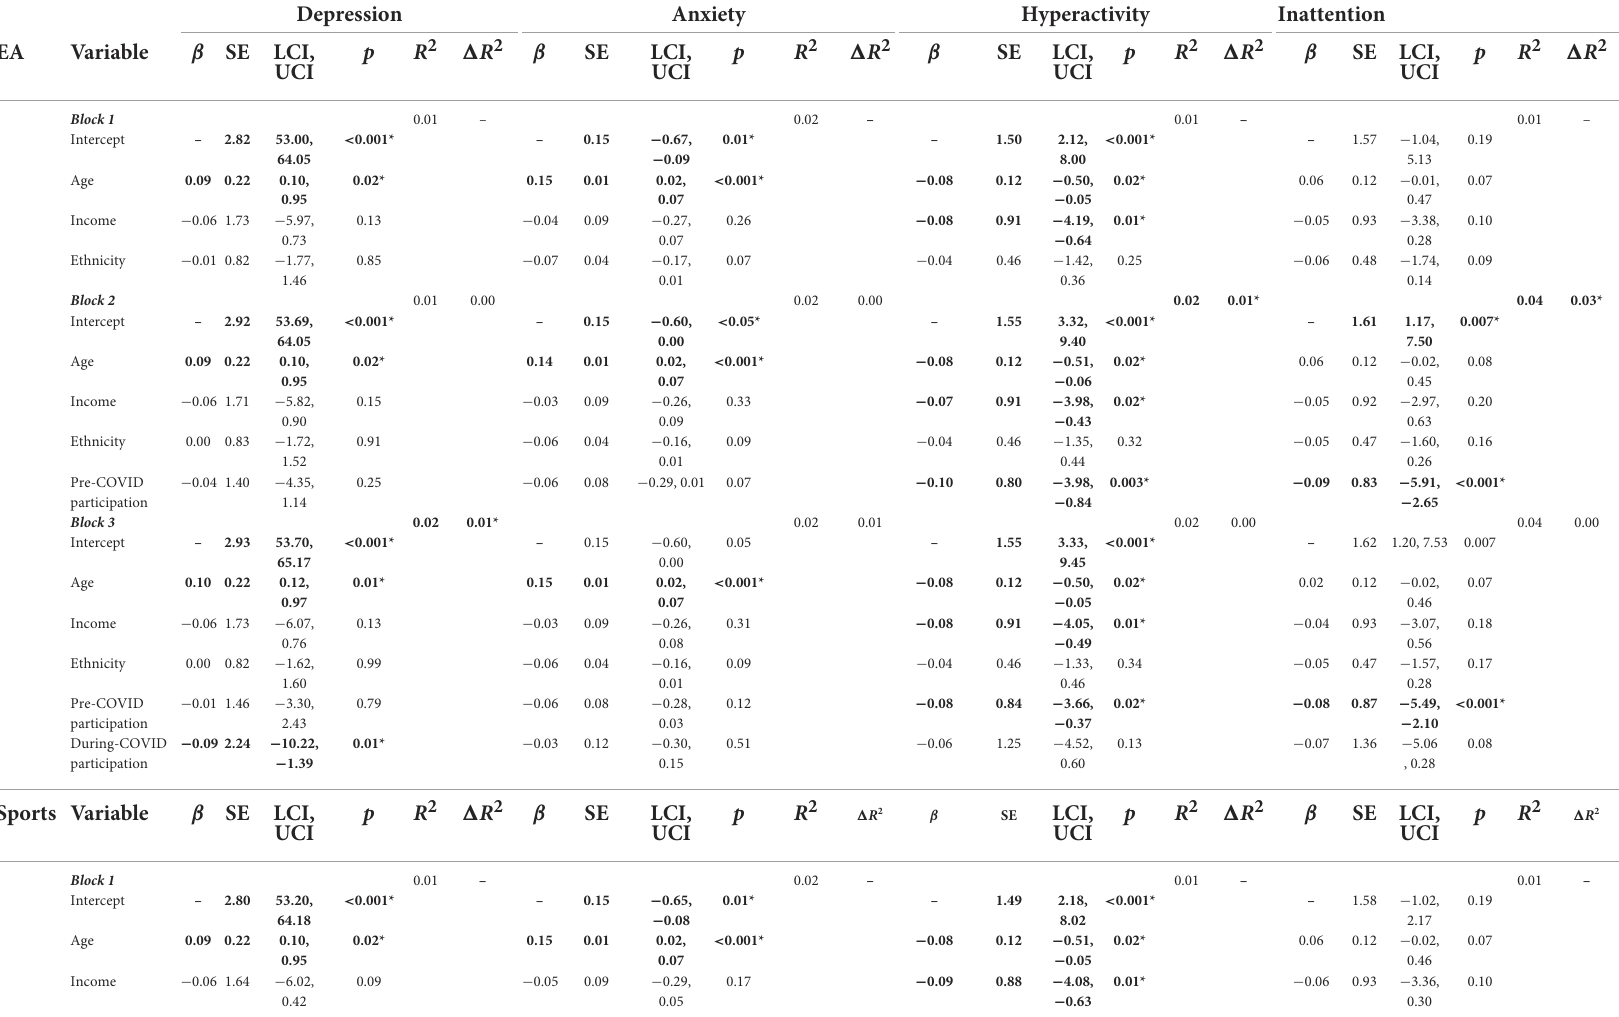
TABLE 3 The associations of activity participation and MH outcomes using multiple imputation hierarchical linear regression